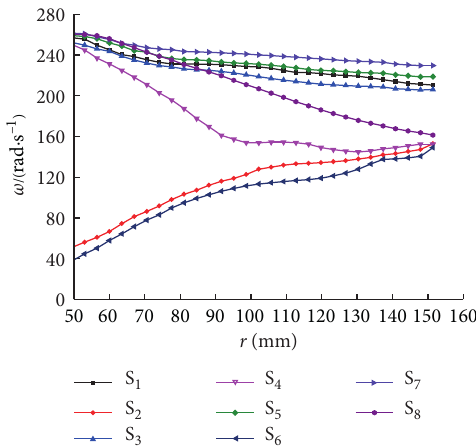
Figure 10: Distribution of liquid rotation coefficient in pump